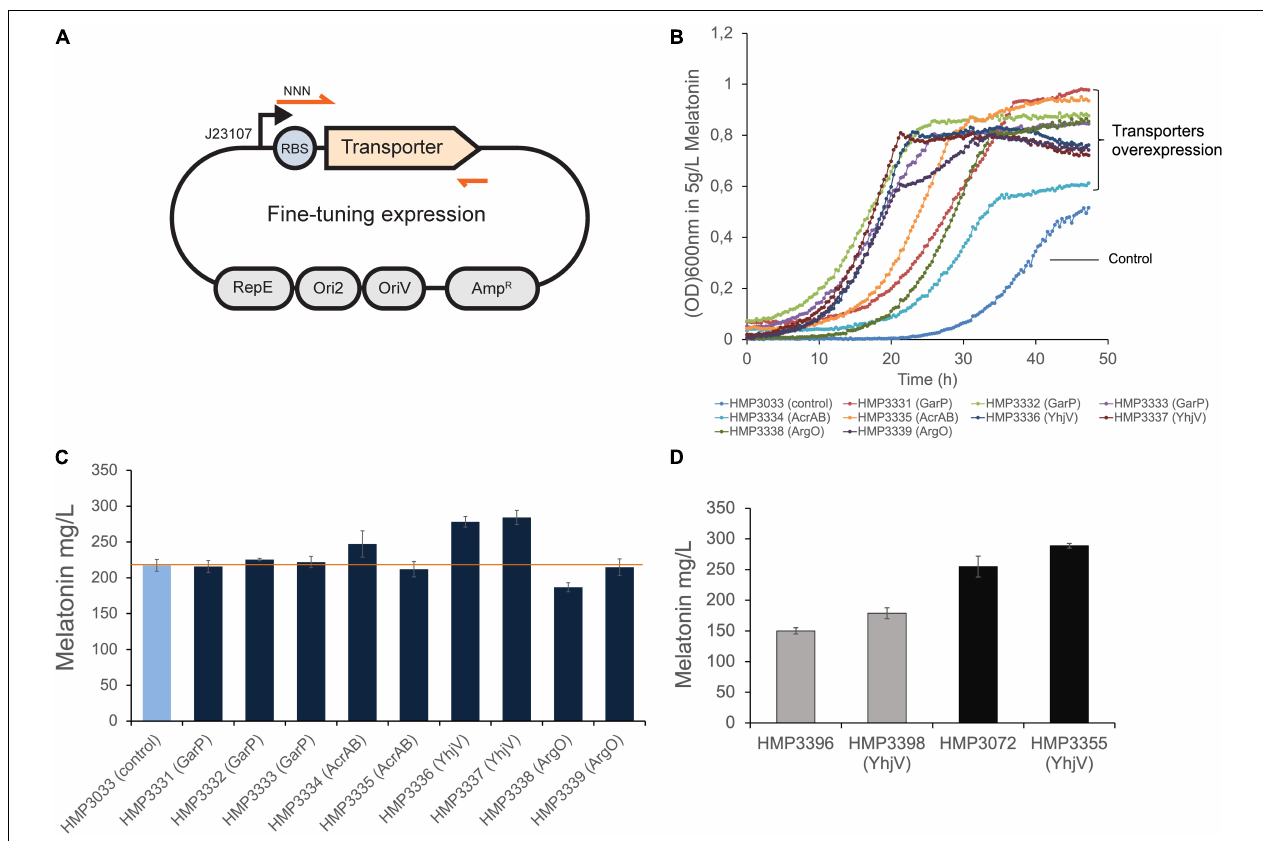
FIGURE 5 | Overexpression of transporters and their impact on melatonin production. (A) The transporter genes were cloned in a low copy plasmid backbone (Womble and Rownd, 1987) with RBS containing degenerate sequences under the control of the J23107 promoter. (B) The selected resulting strains with AcrAB, YhjV, GarP and ArgO overexpression gave rise to increased tolerance to 5 g/L melatonin. (C) The selected strains from (B) were further tested for melatonin production in small-scale assays. Extra-cellular melatonin was measured in this assay. The 2 YhjV overexpression strains showed over 20% improvement in titer. (D) The transporter plasmid in HMP3337 was extracted and transformed into 2 other melatonin production strains, offering about 13 and 19% titer increase, respectively. Presented data are mean ± s.d. ( N = 3). Promoter and RBS sequences are listed in Supplementary Material